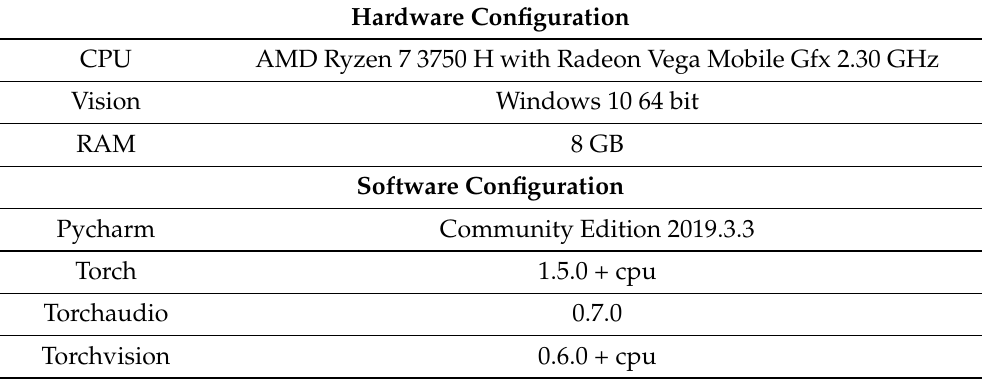
Table 2. Software and hardware configuration.